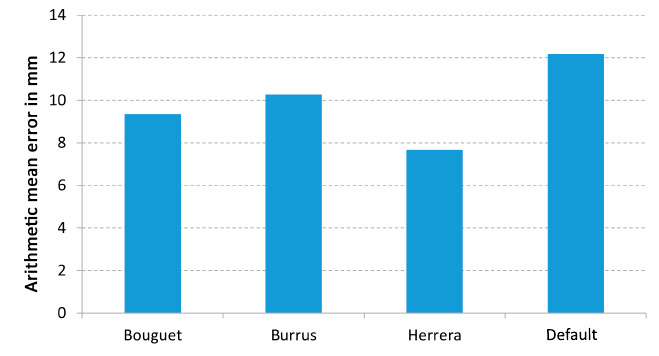
Figure 10. Plane fitting test error for each calibration method for all cameras.